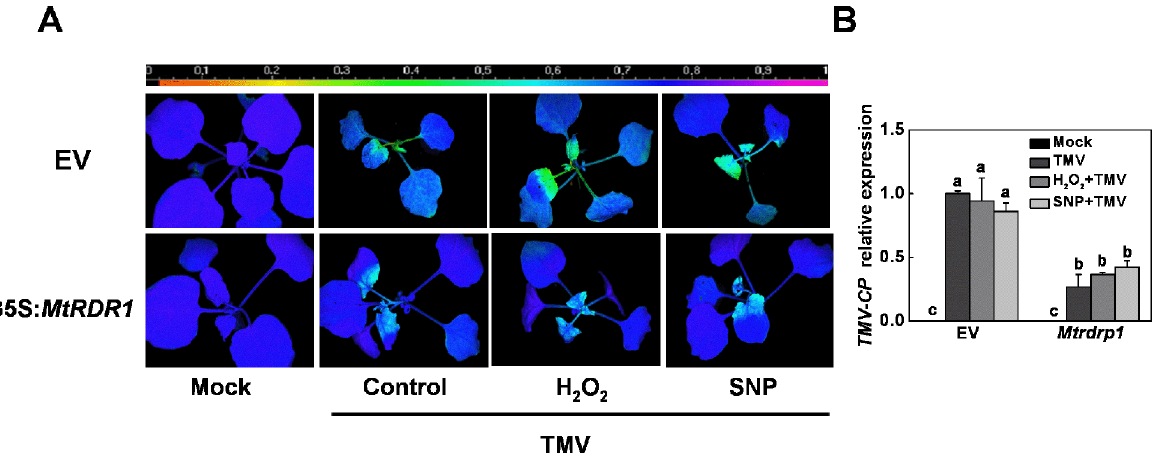
Figure 7. Effects of exogenous H 2 O 2 and NO on TMV infection in Nicotianabenthamiana plants. Effects of exogenous application of hydrogen peroxide (H 2 O 2 ) and nitric oxide (NO) and TMV inoculation on the maximum photochemical efficiency of photo system II (Fv/Fm) and TMV- CP gene transcription in the non-inoculated upper leaves of empty vector (EV)-transformed and MtRDR1 -transformed Nicotiana benthamiana plants. The non-inoculated upper leaves were pretreated with hydrogen peroxide (H 2 O 2 ) or nitric oxide (NO) 12 hours before TMV inoculation. A . Chlorophyll fluorescence images of the maximum quantum yield of PSII (Fv/Fm) at 7 days post inoculation. The color gradient scale at the top indicates the magnitude of the fluorescence signal represented by each color. B . TMV-CP transcript levels analyzed by real-time reverse-transcription polymerase chain reaction at 7 days post inoculation. The results are expressed as the mean 6 SD, n = 4. The letters indicate significant differences between the treatments ( P ,